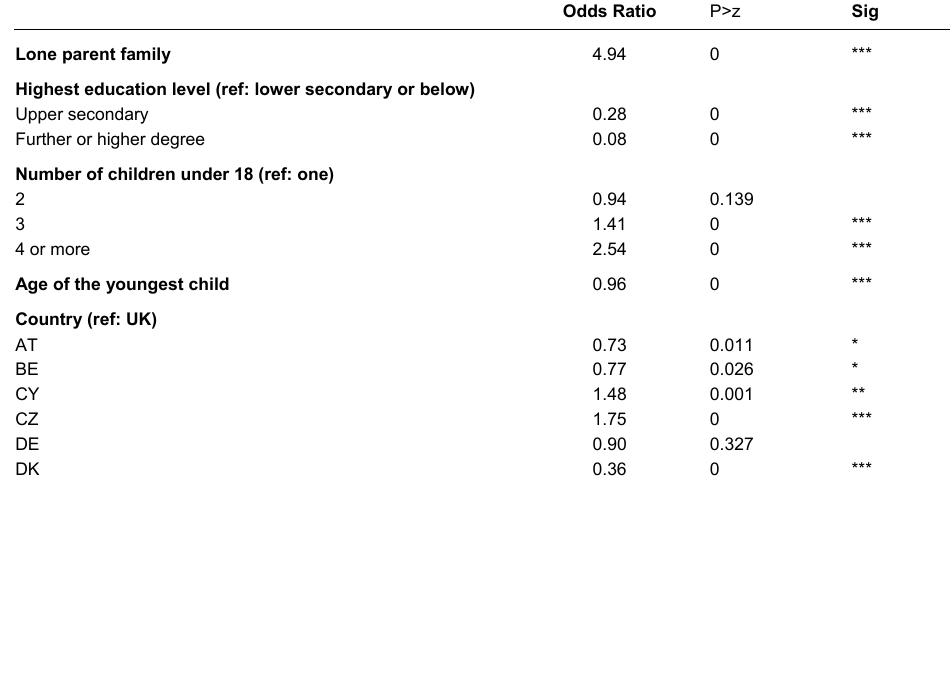
Table 2 : Logistic odds of a child living in a family lacking two or more dimensions. Odds Ratio P>z Sig Lone parent family 4.94 0